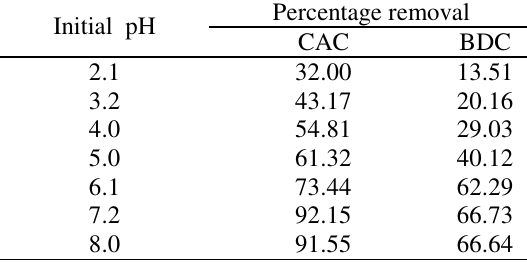
Table 4 . Effect of initial pH on the extent of removal of lead(II) ions by CAC and BDC at 30 °